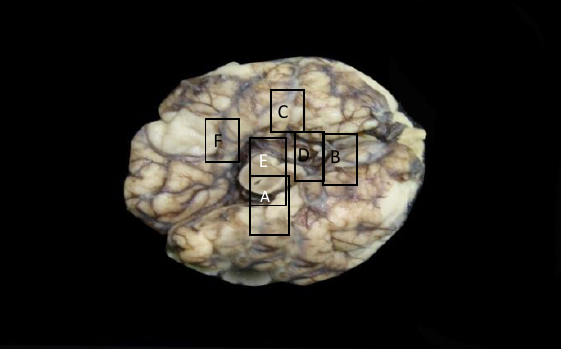
Figure, 2: Cerebral, A: Cerebral aqueduct, B: Optic nerve, C: Parahippocompus gyrus, D: Infundibulum, E: Mid brain (cut), F: Occipto- temporal sulcus.